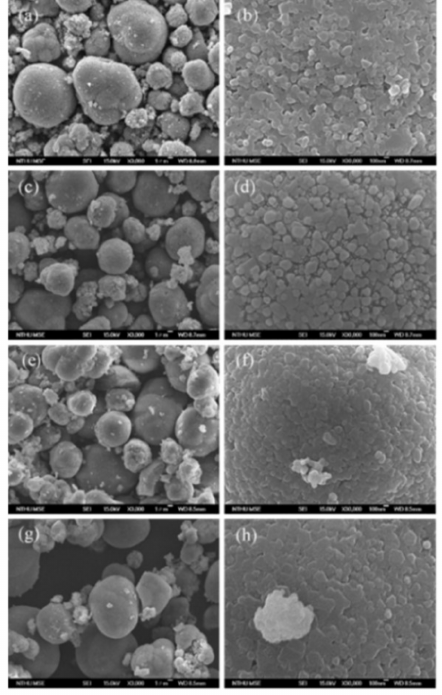
Figure 2. SEM images of ( a , b ) LR–Bare, ( c , d ) LR–Sp1,( e , f ) LR–Sp2.5, and ( g , h ) LR–Sp2.5 cathodes.